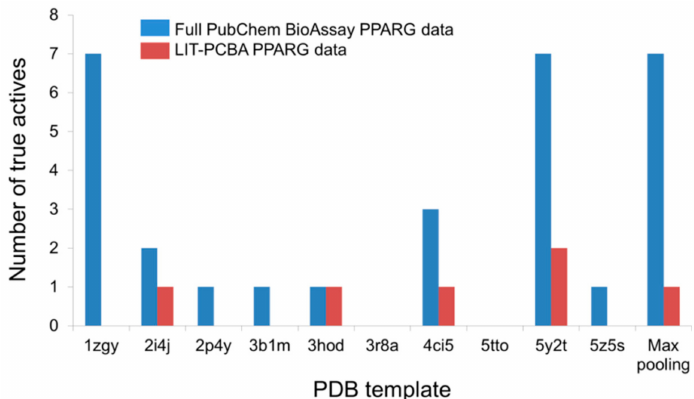
Figure 6. The number of highly potent true actives (EC 50 < 1 µ M) retrieved among the top 1% ranked molecules by a 2D ECFP4 fingerprint similarity search from the full PubChem BioAssay data and the corresponding LIT-PCBA PPARG ligand set after ligand-filtering. Ten known crystallographic PPARg agonists were randomly chosen as templates from 138 available structures on the Protein Data